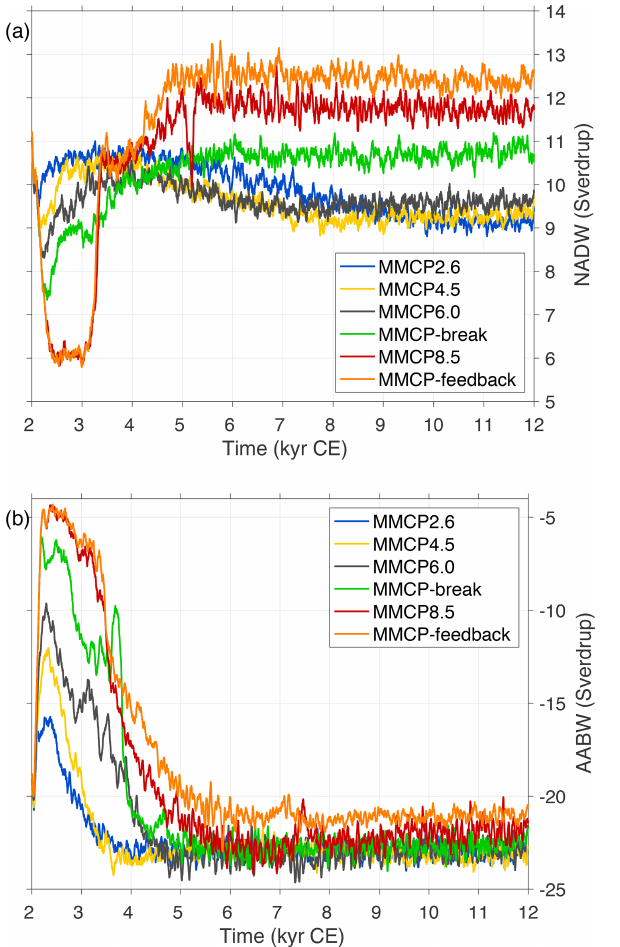
Figure 8. Freshwater flux anomalies with respect to 1970–2000 from (a) the Greenland ice sheet and (b) the Antarctic ice sheet for the six different forcing scenarios.